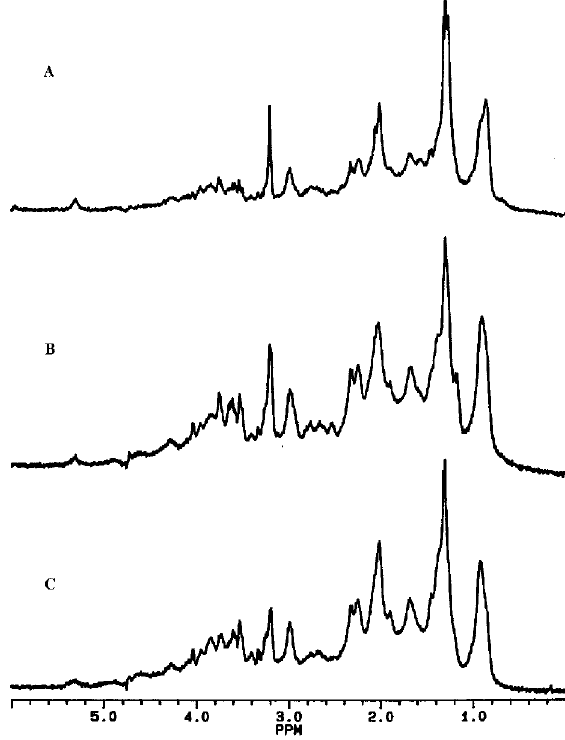
Fig. 2. Proton MR spectra (360 MHz, 25 ° C) of soft tissue sarcoma of different histological types: (A) malignant (cid:142) brous histocytoma, (B) leiomyosarcoma, and (C) (cid:142) brosarcoma. Spectral peak assignments are the same as in Fig. Table 2, the best P value was obtained for the 0.9/2.0